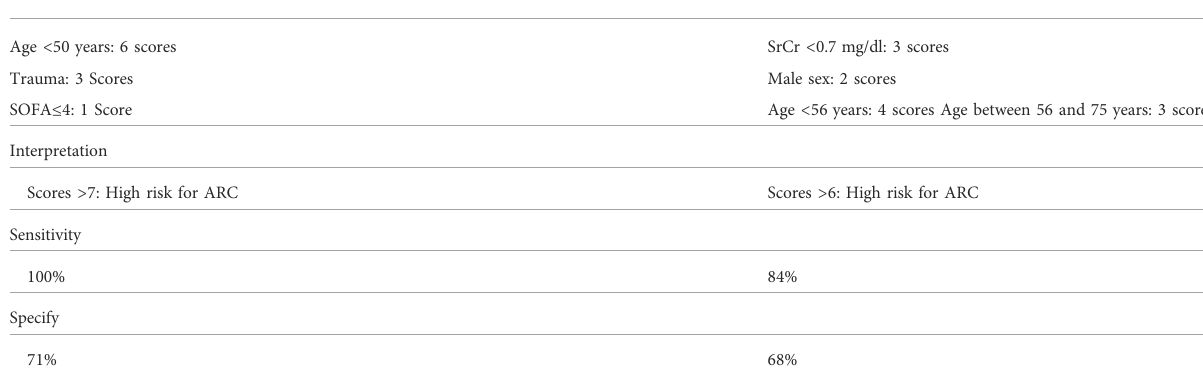
TABLE 1 The ARC and ARCTIC scores for prediction of occurrence of ARC. ARC